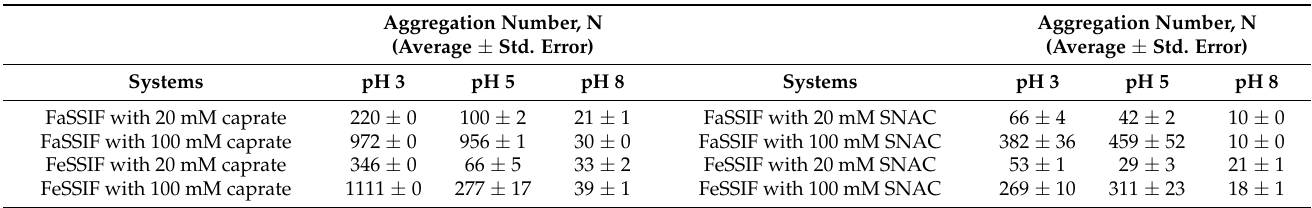
Table 2. Aggregation numbers for all studied systems, presented as an average value and standard error 1 calculated using the last 200 ns of the simulation trajectory. Aggregation Number, N (Average ± Std. Error)